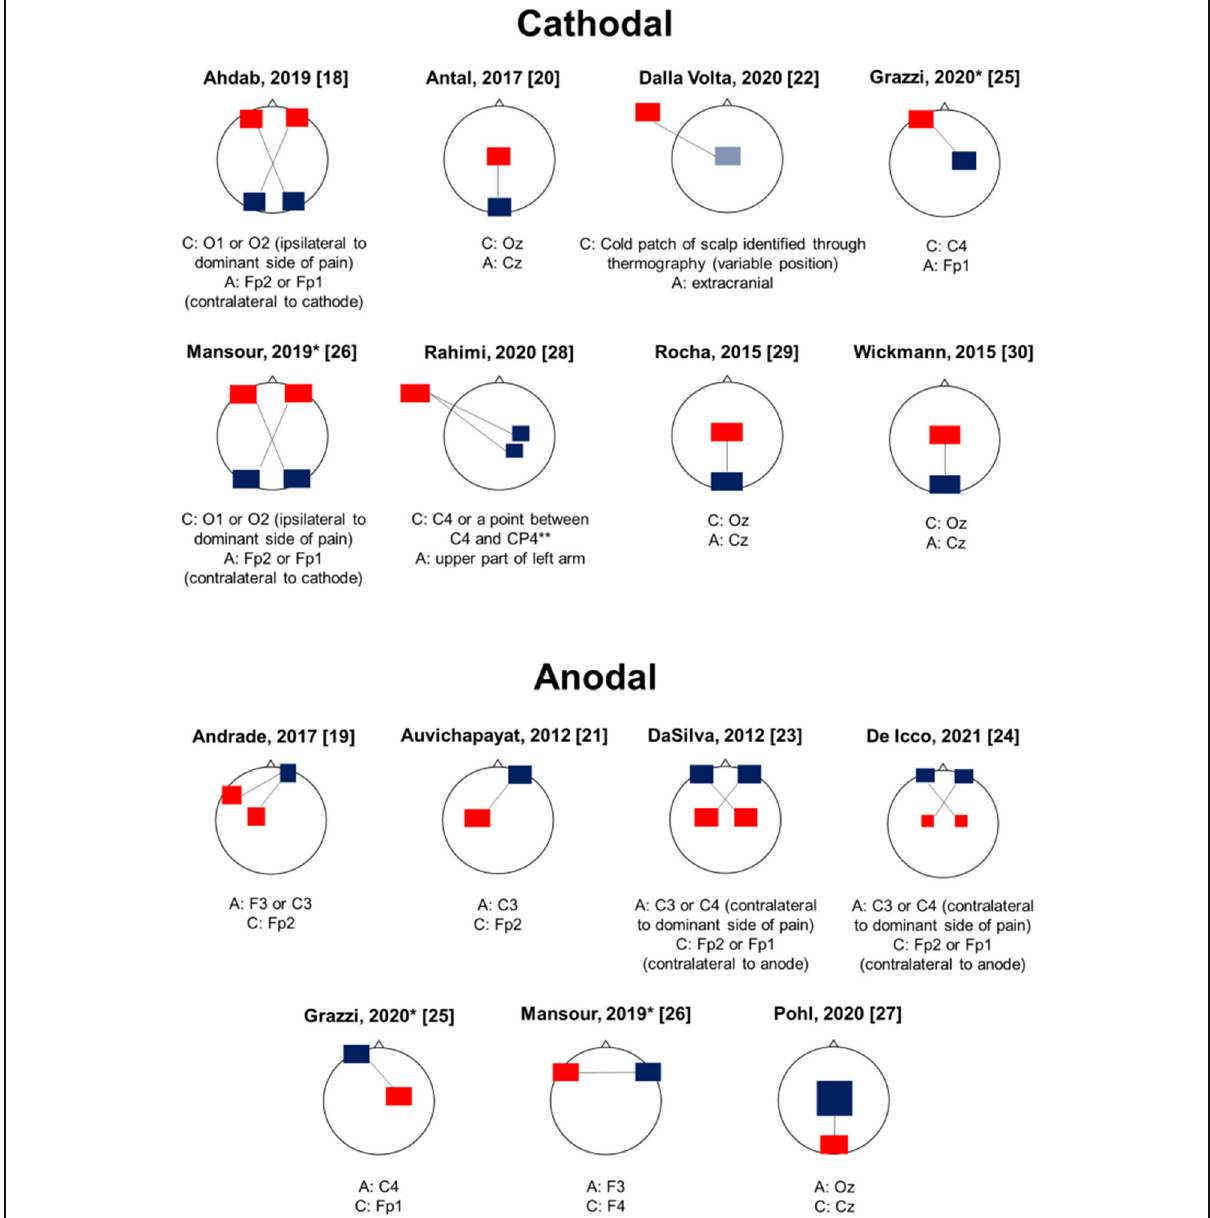
Fig. 3 Overview of transcranial direct current stimulation montages in the included randomized controlled trials. Blue squares/rectangles indicate cathodes, while red squares/rectangles indicate anodes. Electrodes ’ shape and dimension reflect the differences in RCTs stimulation setups. Solid lines connect the electrodes pairs that have been tested in different stimulation conditions in each RCT. The positions of anodes and cathodes are identified according to the international 10/20 electroencephalographic system. *This study assessed both cathodal and anodal stimulation. **10/10 electroencephalographic